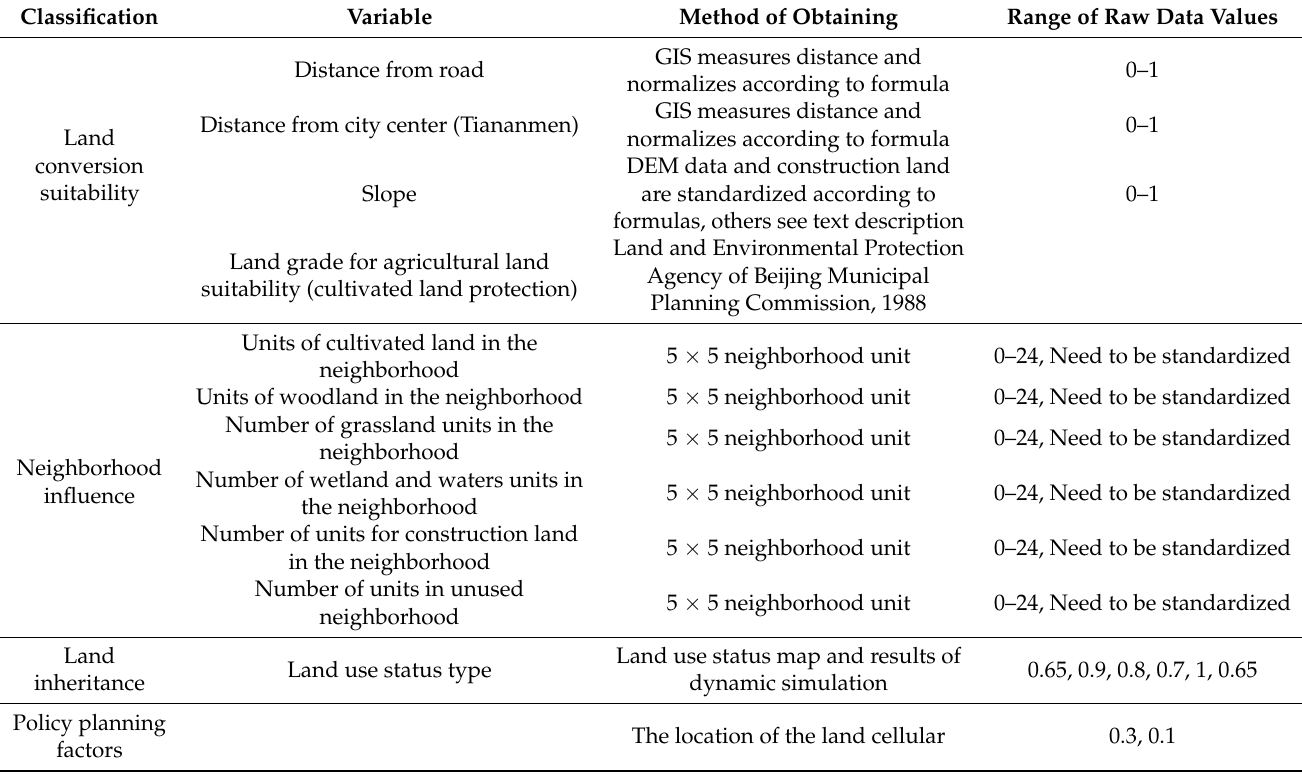
Table 3. Mode of Variable Acquisition in the CA Model of Green Space Simulations in Beijing’s Central District.